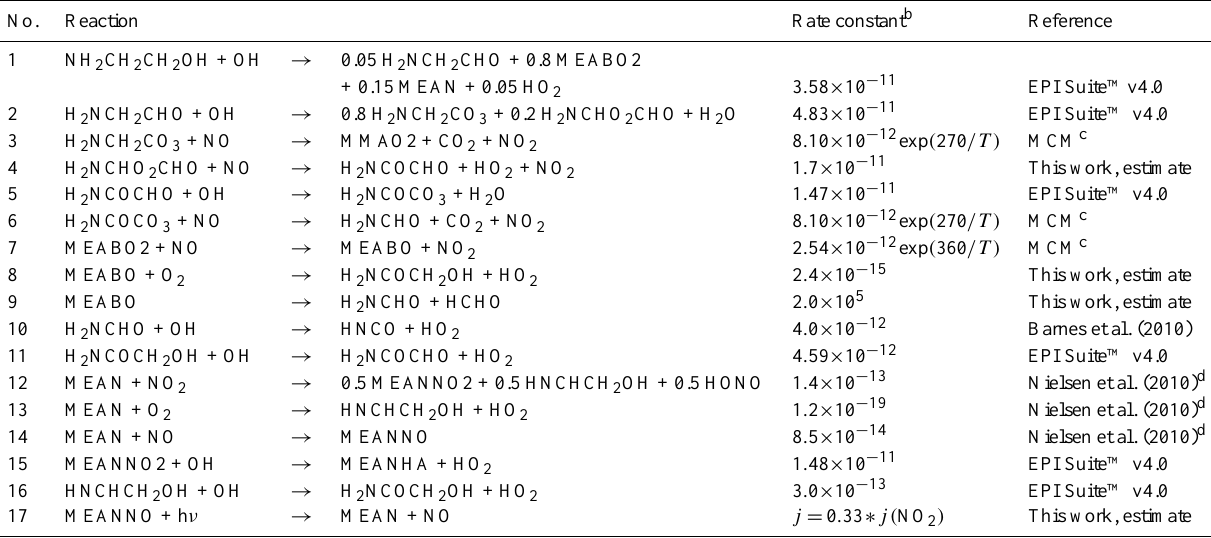
Table 3. Mechanism for OH-initiated oxidation of MEA used to simulate chamber experiments on the photo-oxidation of MEA a . Reactions with gas-phase products and temperature dependent rate